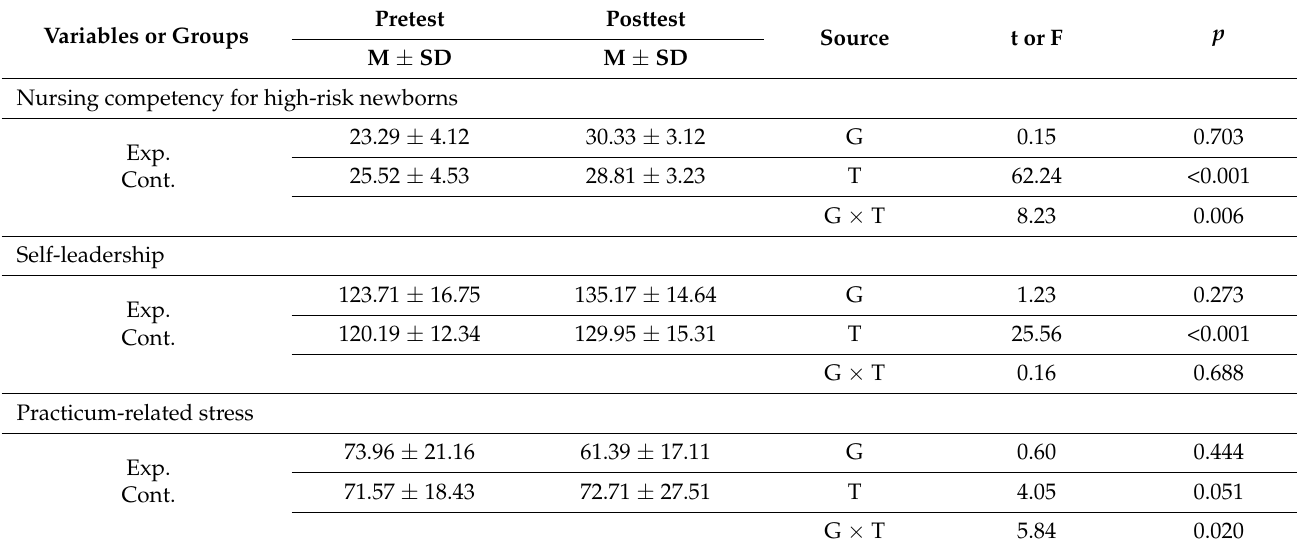
Table 3. Nursing competency for high-risk newborns, self-leadership, and practicum-related stress between two groups ( n =